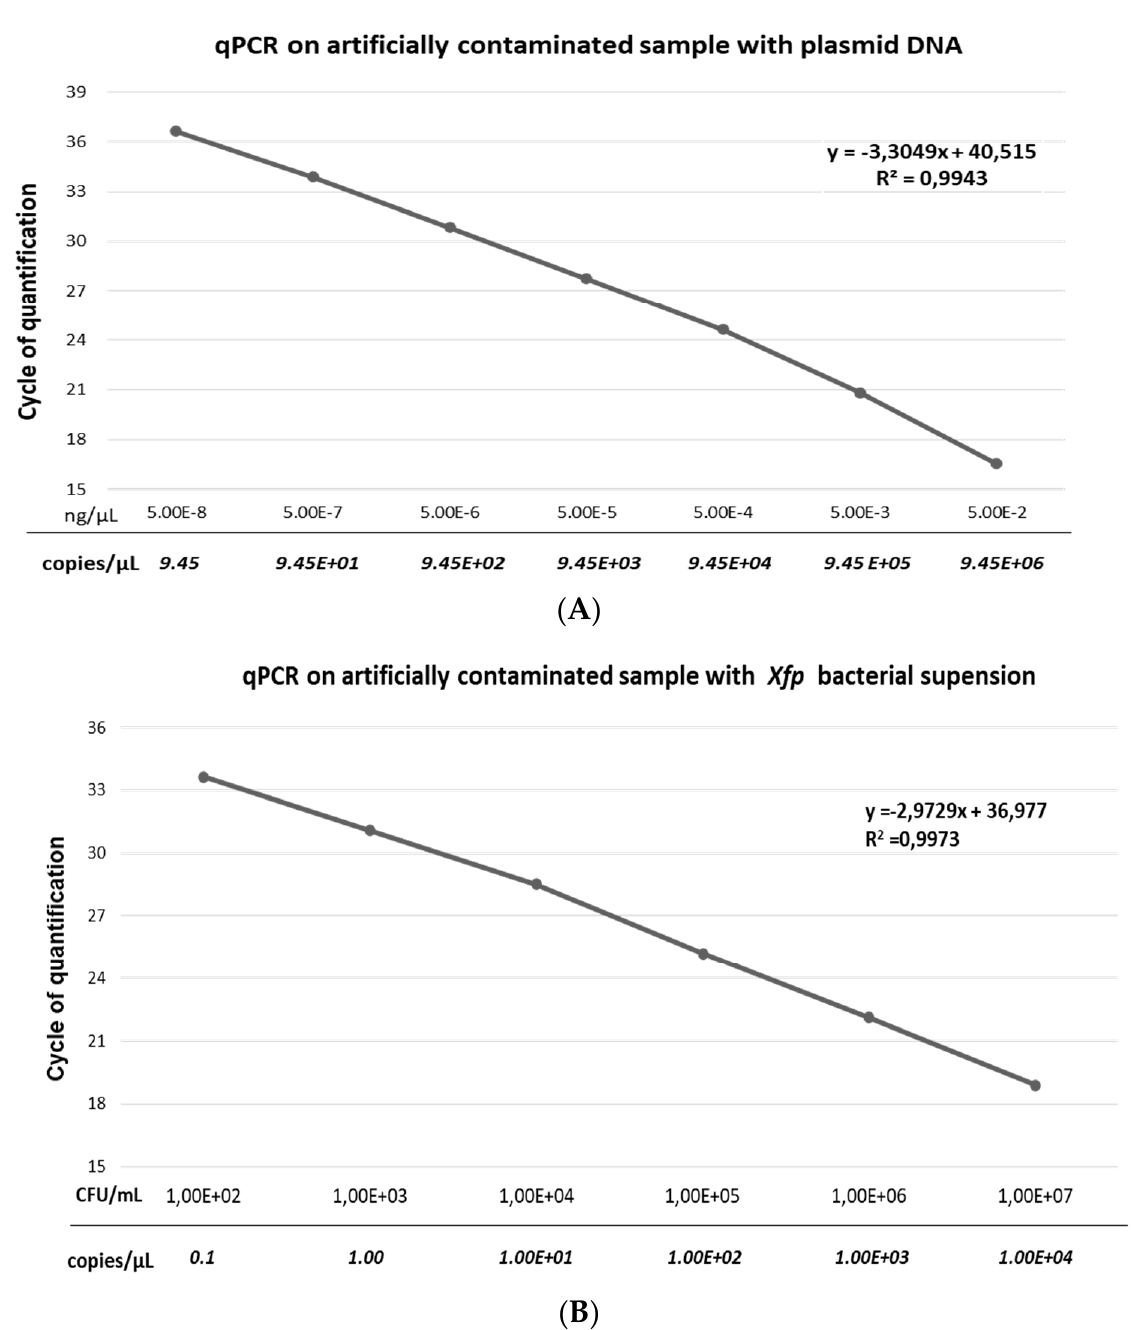
Figure 2. Standard curves generated by qPCR assay on rimM plasmid DNA ( A ) and bacterial suspension ( B ). Plasmid DNA was ten-fold serially diluted from 50 pg/µL to 50 ag/µL (9.45 × 10 6 – 9.45 copies/µL). The bacterial suspension was ten-fold serially diluted from 1.00 × 10 7 to 1.00 × 10 1 CFU/mL (1.00 × 10 4 –0.1 copies/µL). On the y-axis: the cycle of quantification. ( A ) On the x-axis, ng/µL and copies/µL (italic and bold) are indicated. ( B ) On the x-axis, CFU/mL and copies/µL (italic and bold) are reported.